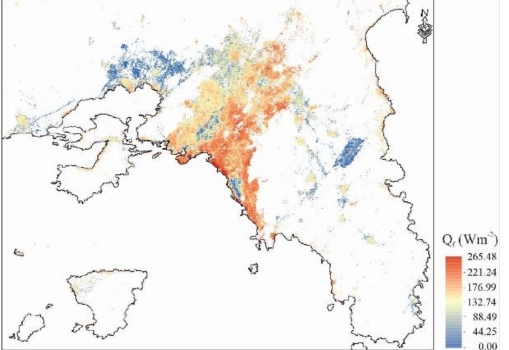
Figure 5. Spatial distribution of the anthropogenic heat for the Greater Athens Area for 26 July 2001.